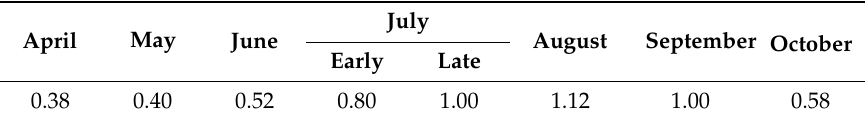
Table 4. Crop coefficients ( Kc